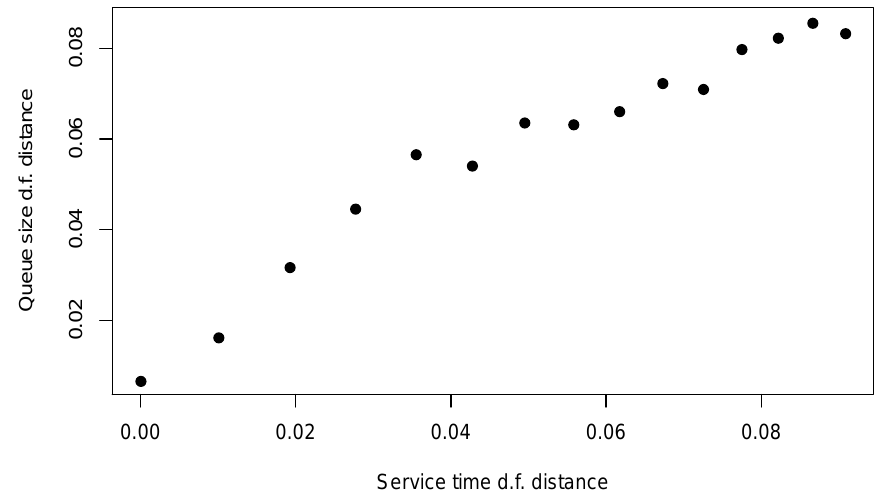
Figure 5. Distance between the empirical queue size d.f. in a basic M / G / c system with c = 4, ρ = 0.5, F 1 being Pareto ( 2.1,1 ) service time d.f. and λ = 2.2, and system with a mixture, F M of Pareto ( 2.1,1 ) and Pareto ( α 2 ,1 ) service time d.f. vs. the distance between F 1 and F M , for fixed p = 0.7 and varying α 2 = 2.1,2.3, . . . ,4.9.